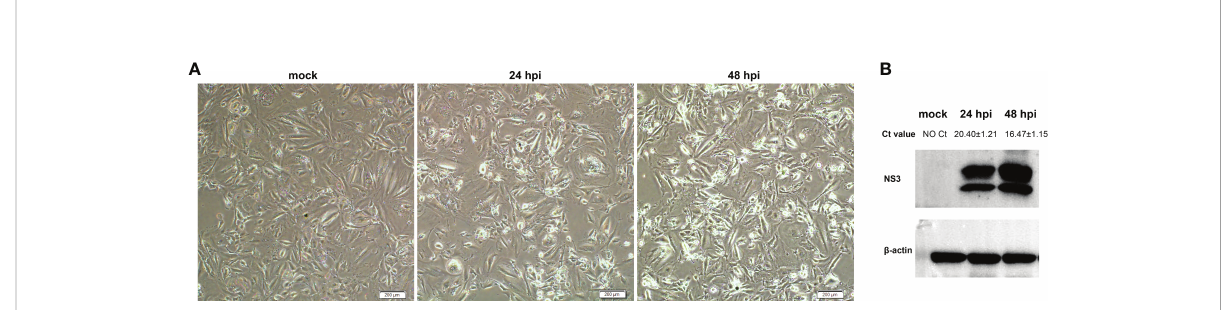
FIGURE 1 Validation of BTV-1 infection in OA3.Ts cells at 0, 24 and 48 dpi. (A) CPEs were observed in OA3.Ts cells infected with BTV-1 (Y863 strain) under microscope at 0, 24 and 48 hpi (×4 magni fi cation). Scale bar, 200 m M. (B) qRT-PCR and WB were also used to verify the successful infection of BTV-1 (Y863 strain) in OA3.Ts cells. The infection status of BTV-1-infected- and mock-infected groups at different time points was represented by mean Ct values ± SD from three independent experiments. NS3 was detected as control for successful infection, whereas b -actin served as an internal